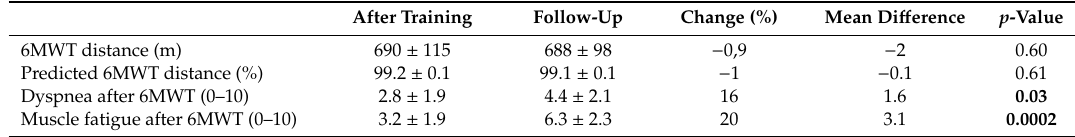
Table 6. Comparison of 6MWT distance, dyspnea score, and muscle fatigue score immediately after the program and six months after completion ( n = 15). Expressed as absolute and relative (percentage of predicted values) values. After Training Follow-Up Change (%) Mean Di ff erence p -Value 6MWT distance (m) 690 ± 115 688 ± 98 −